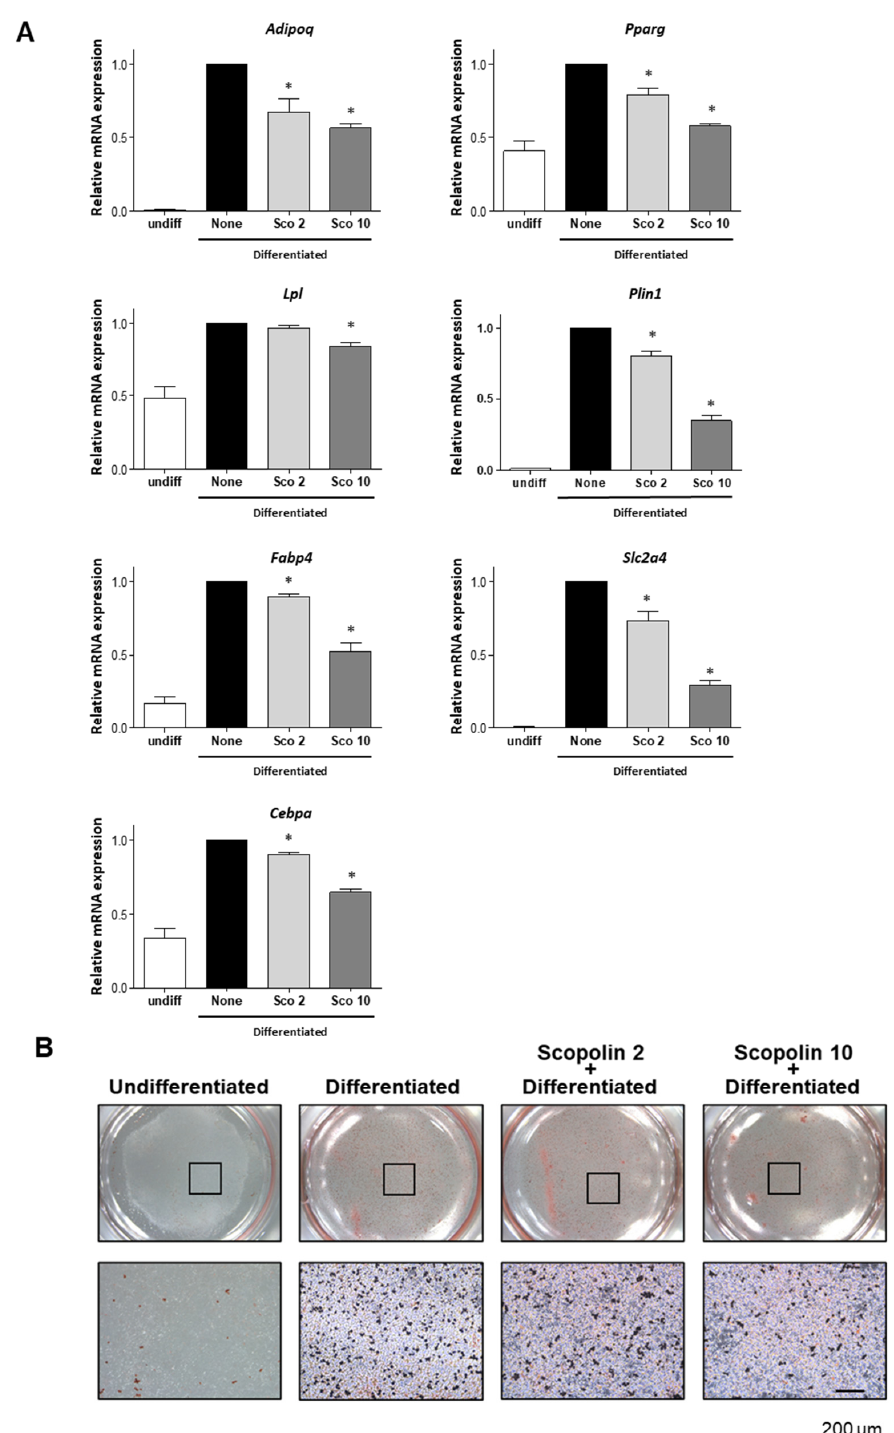
Figure 2. Scopolin inhibited adipocyte differentiation under in vitro conditions. 3T3-L1 preadipocyte cells were differentiated into adipocytes and treated with different concentrations of scopolin (2 or 10 μ M) during lipid accumulation. ( A ) The mRNA expression levels of adipogenic markers were assessed by qRT-PCR using targeted gene-specific primers. The relative gene expressions were normalized by mouse glyceraldehyde 3-phosphate dehydrogenase ( Gapdh ) gene. * p < 0.05 vs. none (Tukey’s honest significant difference (HSD) post-hoc test and ANOVA). ( B ) Intracellular lipid droplets of differentiated adipocytes were stained with oil red O. Abbreviations: Undiff, undifferentiated; None, non-treated.